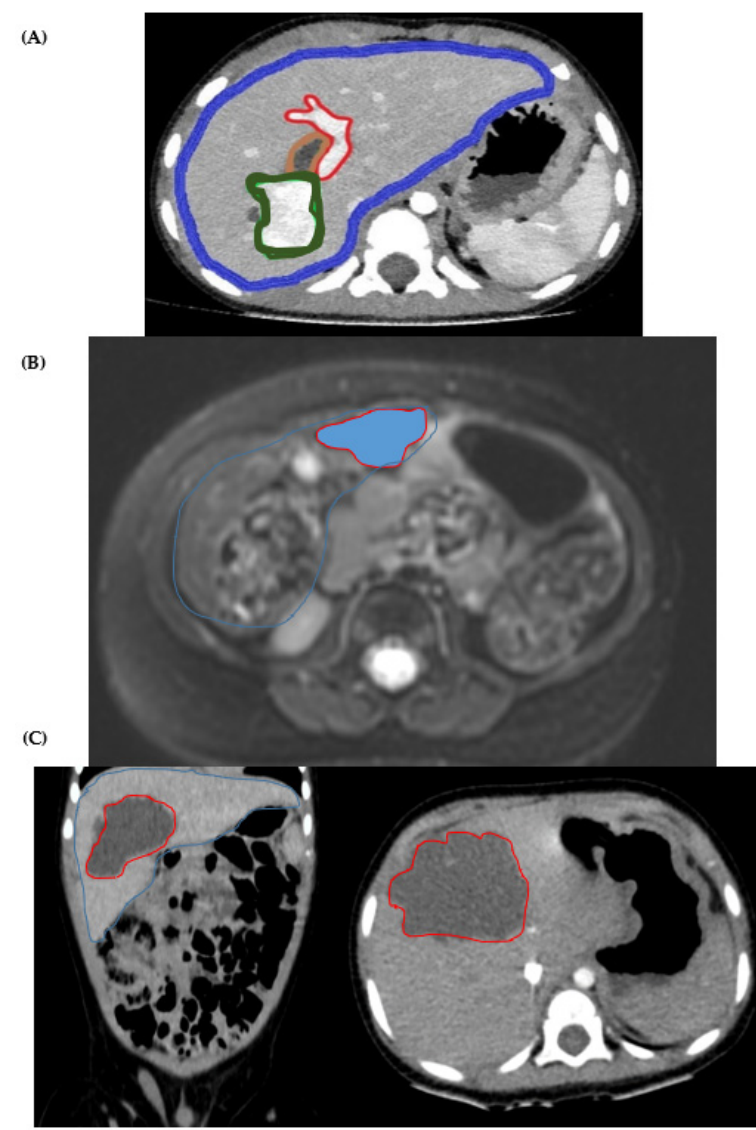
Figure 5. ( A ) CT image with the different anatomical parts highlighted: (1) Liver is outlined in blue; (2) Portal system is circled in red; (3) Dilated intrahepatic biliary tract (tumour) is outlined in brown; and (4) the rest of the tumour, which originates in the biliary tract, is circled in green. (Left) Coronal or frontal plane. (Right) Axial plane. ( B ) MRI of the case (Axial plane). The tumour is contoured in red. The liver is contoured in blue. ( C ) Left: MRI of the case (Frontal plane). Right: MRI of the case (Axial plane). The tumour is contoured in red. The liver is contoured in blue. The workflow of the surgical planning prototypes can be seen in Figure 6. The different parts of the prototypes are highlighted in different colours so that the different anatomical structures are clearly distinguished. Regarding case #1, the part of the image segmentation of Figure 6A depicts the different anatomical parts: (1) the aorta and hepatic artery are in red, (2) the portal vein is in purple, (3) the vena cava and supra-hepatic veins are in blue, (4) the biliary tract can be found in brown, dilated by tumour obstruction, and finally, (5) green corresponds to the tumour. Case #2 in Figure 6B shows: (1) the portal vein in purple, (2) the vena cava and supra-hepatic veins in blue and (3) the tumour in light blue. Case #3 in Figure 6C shows: (1) the portal vein is in purple, (2) the vena cava and supra hepatic veins are in blue and (3) the tumour is